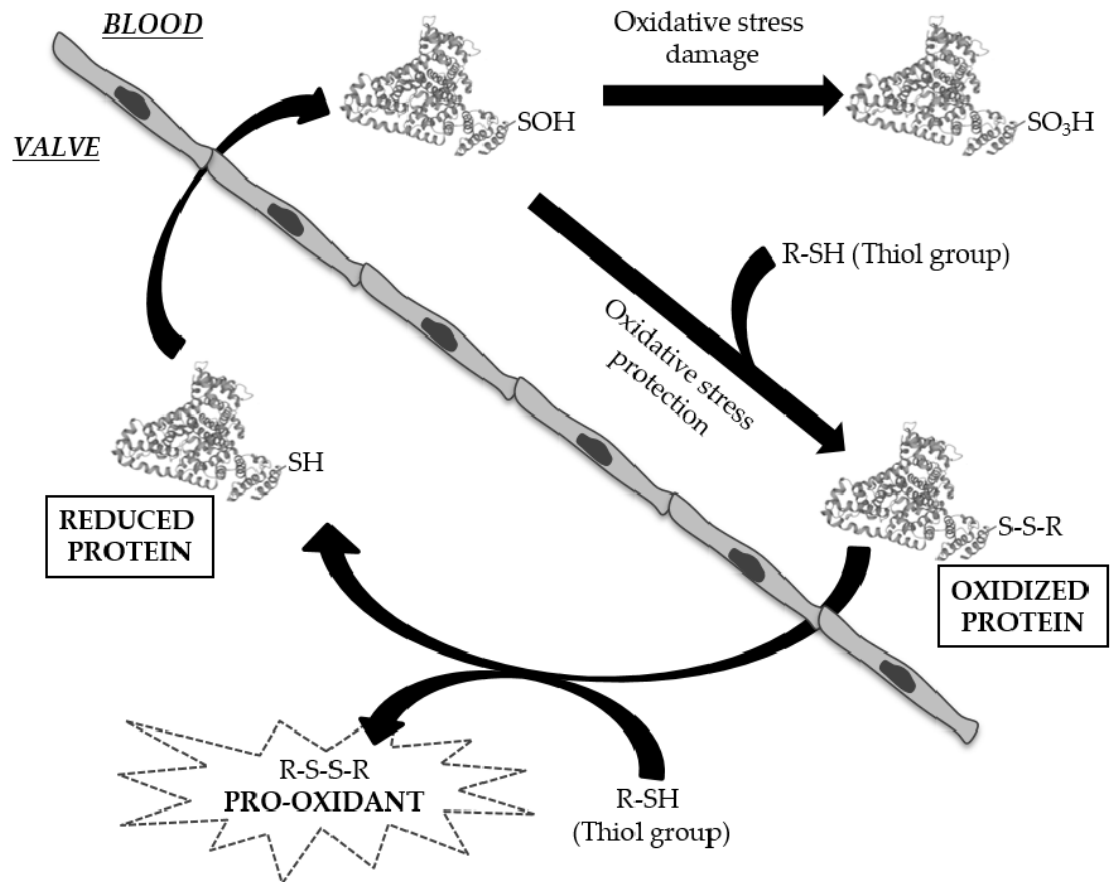
Figure 5. Possible biological significance of Cys modifications. Thiolation of circulating albumin (HSA) may confer protection against oxidative stress. These low ‐ molecular ‐ weight thiols may be released into the aortic valve and generate a pro ‐ oxidant milieu.